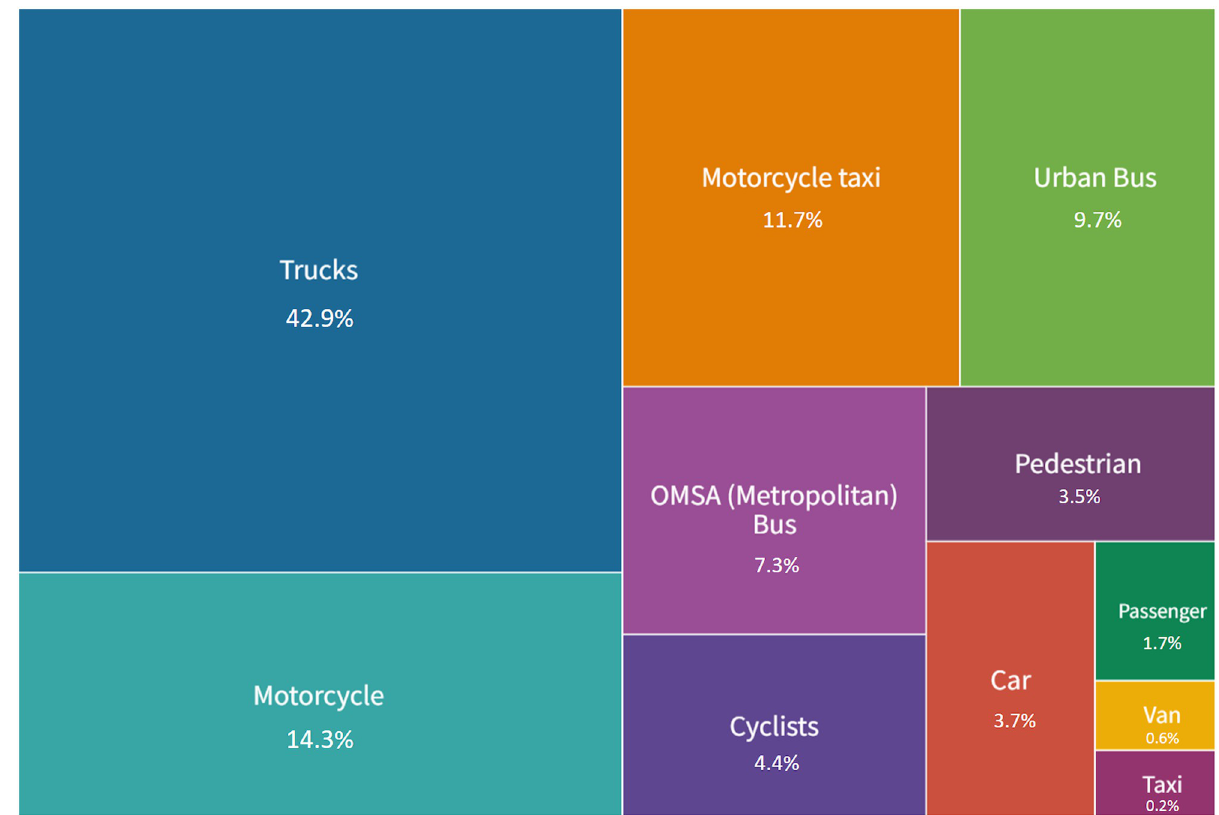
Fig 3. Perception of Dominicans on road users responsible for road